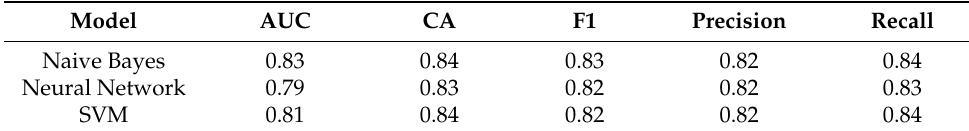
Table 4. Performance evaluation of the algorithms.